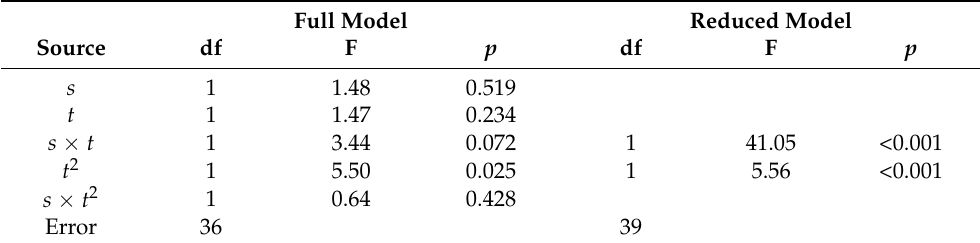
Table 1. Analysis of variance for the effects of time ( t , ordinal date) as a covariate, and host species ( s ) on spruce budworm population survival from predation in Armagh 1986 (Equations (1) and (2)) (R 2 = 0.66). Regression residuals were normally-distributed (AD = 0.37, df = 42, p = 0.42). The reduced model is Equation